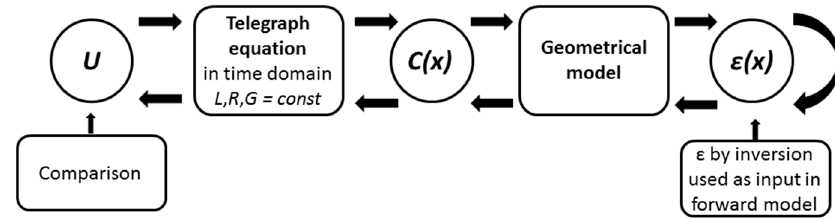
Figure 8. Principle of the examination of the error made in the inversion process.